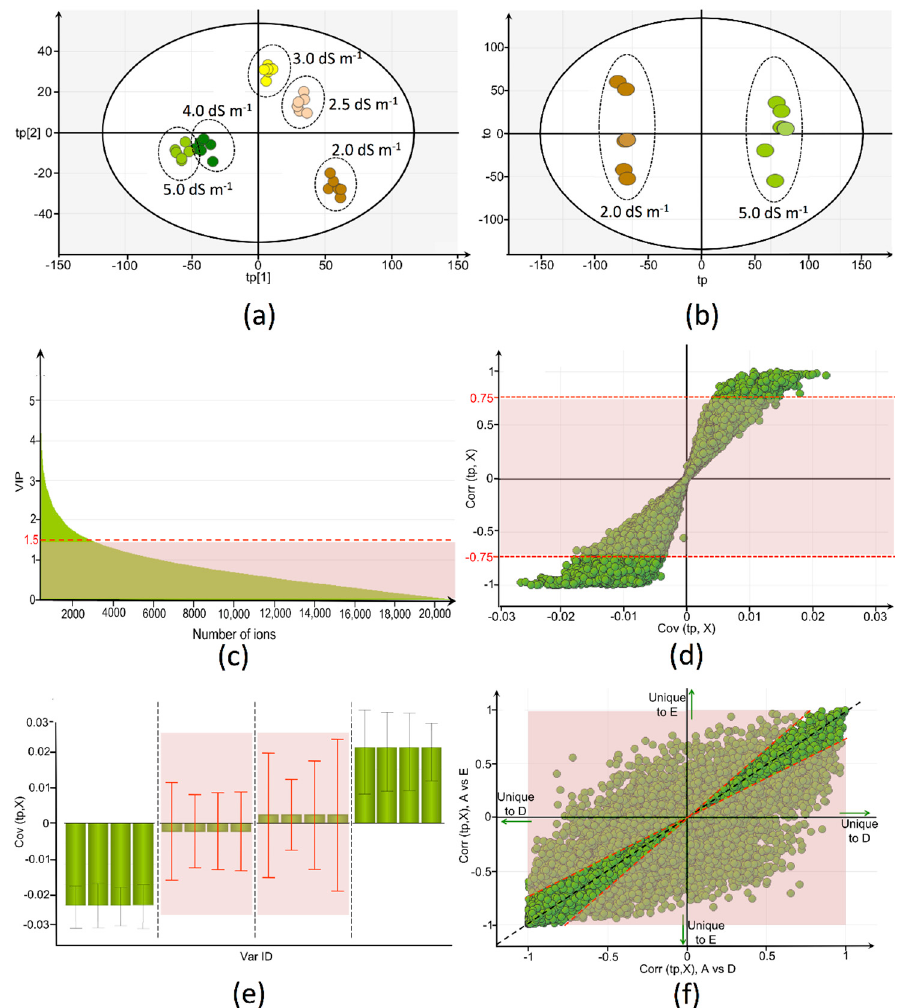
Figure 2. ( a ) Orthogonal partial least squares to latent structures discriminant analysis (OPLS-DA) model that was generated for the initial stage of fruit development (S1), whereby discrimination between the various electrical conductivity (EC)-treatments was achieved on the basis of the metabolic tomato fruit fingerprints. Selection of relevant ions was performed for each of the ( b ) successfully validated two-class models (e.g., 2.0 versus 5.0 dS m − 1 ) using ( c ) variable importance in projection (VIP)-scores; ( d ) S-plot; and ( e ) loading-plot with jack-knifed confidence intervals; ( f ) the SUS-plot was used to visualize the shared information for multiple two-class OPLS-DA models. Shaded areas represent the ions that were considered irrelevant and excluded. For clarity of figures, following labeling of treatments was introduced: A, 2.0 dS m − 1 ; D, 4.0 dS m − 1 ; E, 5.0 dS m − 1 .